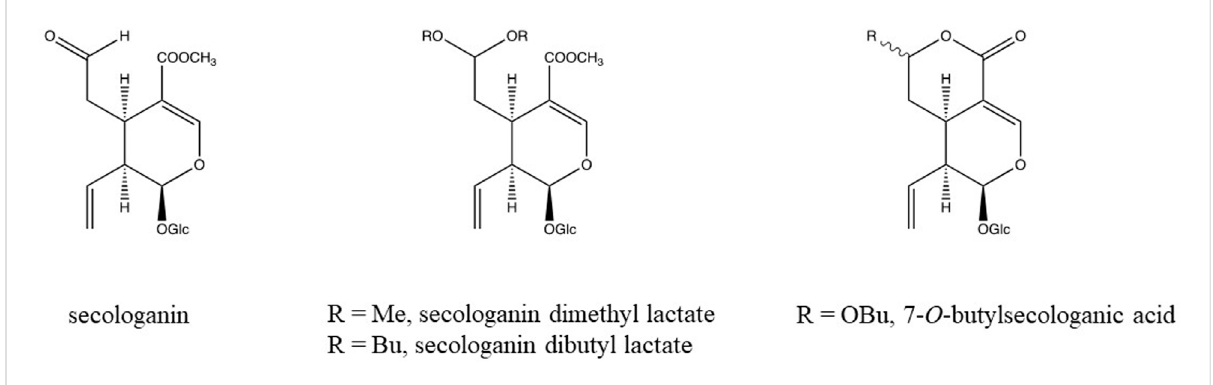
alkaloids and caffeic acid derivatives were used as examples. Sauerschnig and colleagues (2018) reported many other examples of artifact formation with methanol. By using